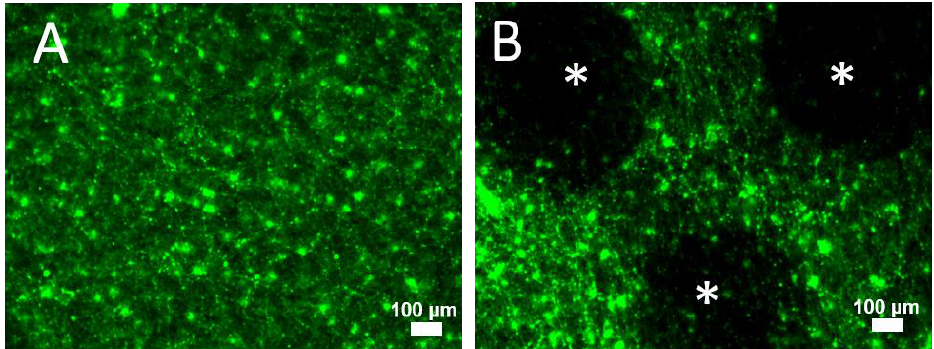
Figure 5. ( A ) Image of FITC-labeled clot at 10× prior to investigation at higher magnification. ( B )